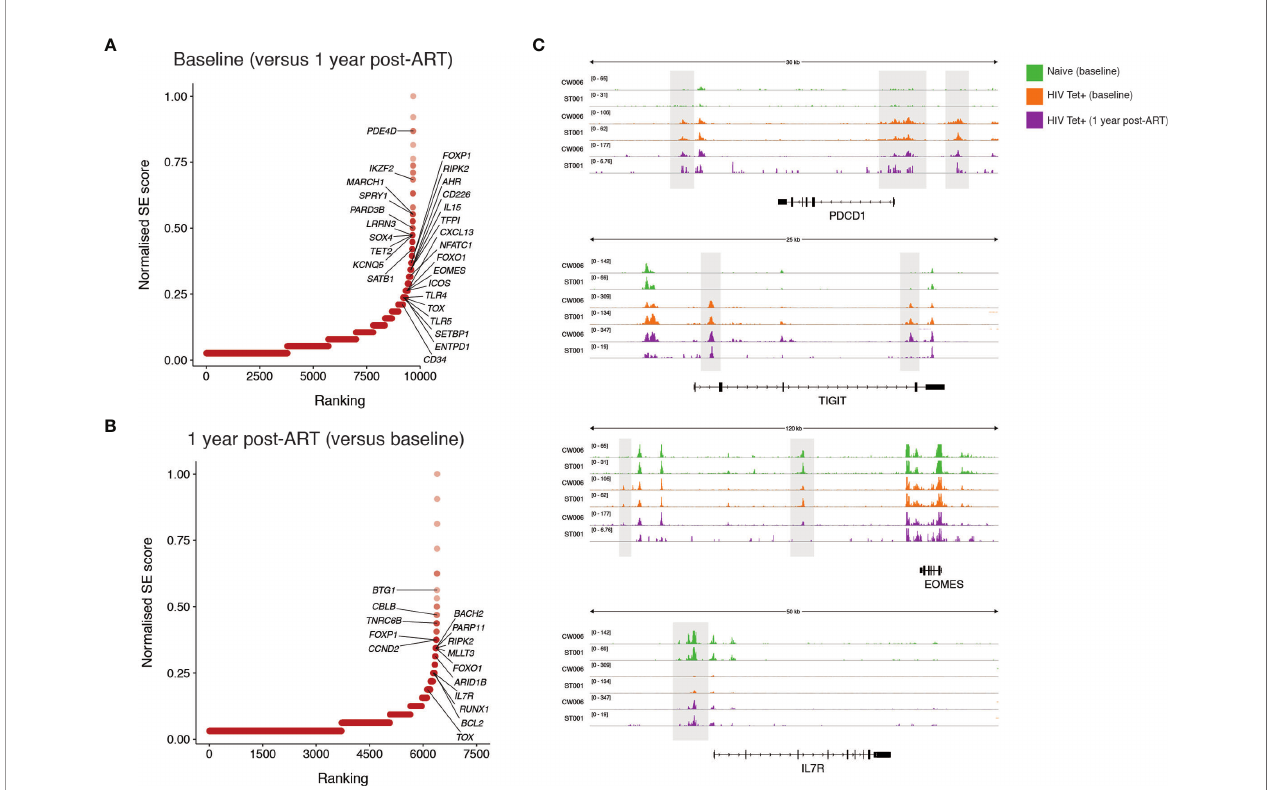
FIGURE 6 | Identi fi cation of super-enhancers which are differentially accessible prior to and following one year of ART initiated during PHI. Super-enhancer elbow plots based on chromatin accessible regions (ChARs) within HIV-speci fi c CD8 T cells which are differentially accessible between baseline and following one year of ART including those that show increased accessibility at baseline compared with one year following ART (A) and which show increased accessibility following one year of ART compared with baseline (B) . (C) Representative ATAC-seq tracks at the PDCD1, TIGIT, EOMES and IL7R gene loci. Numbers in brackets represent the number of reads for peaks that are being